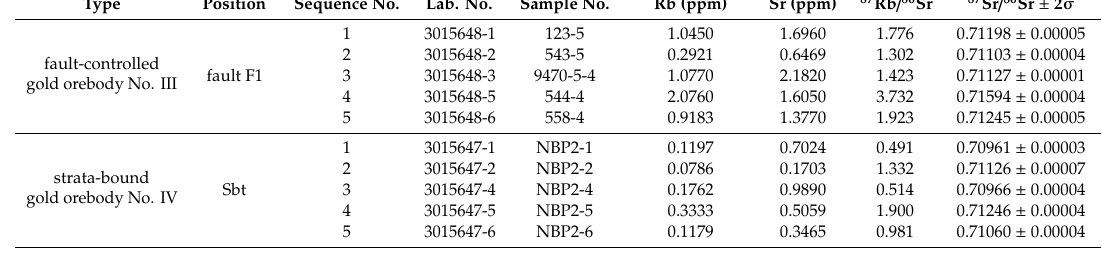
Table 1. The quartz fluid inclusion Rb–Sr isotopic measurement results from the Nibao gold deposit. Type Position Sequence No. fault-controlled gold orebody No. III